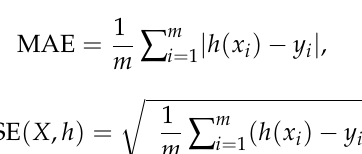
Figure 12. The prediction results of the OS-PELM algorithm and two comparison algorithms for four different kinds of living trees (metasequoia, poplar, pine and beech, with MC levels of 45.9%, 26.1%, 34.7%, and 40.4%).